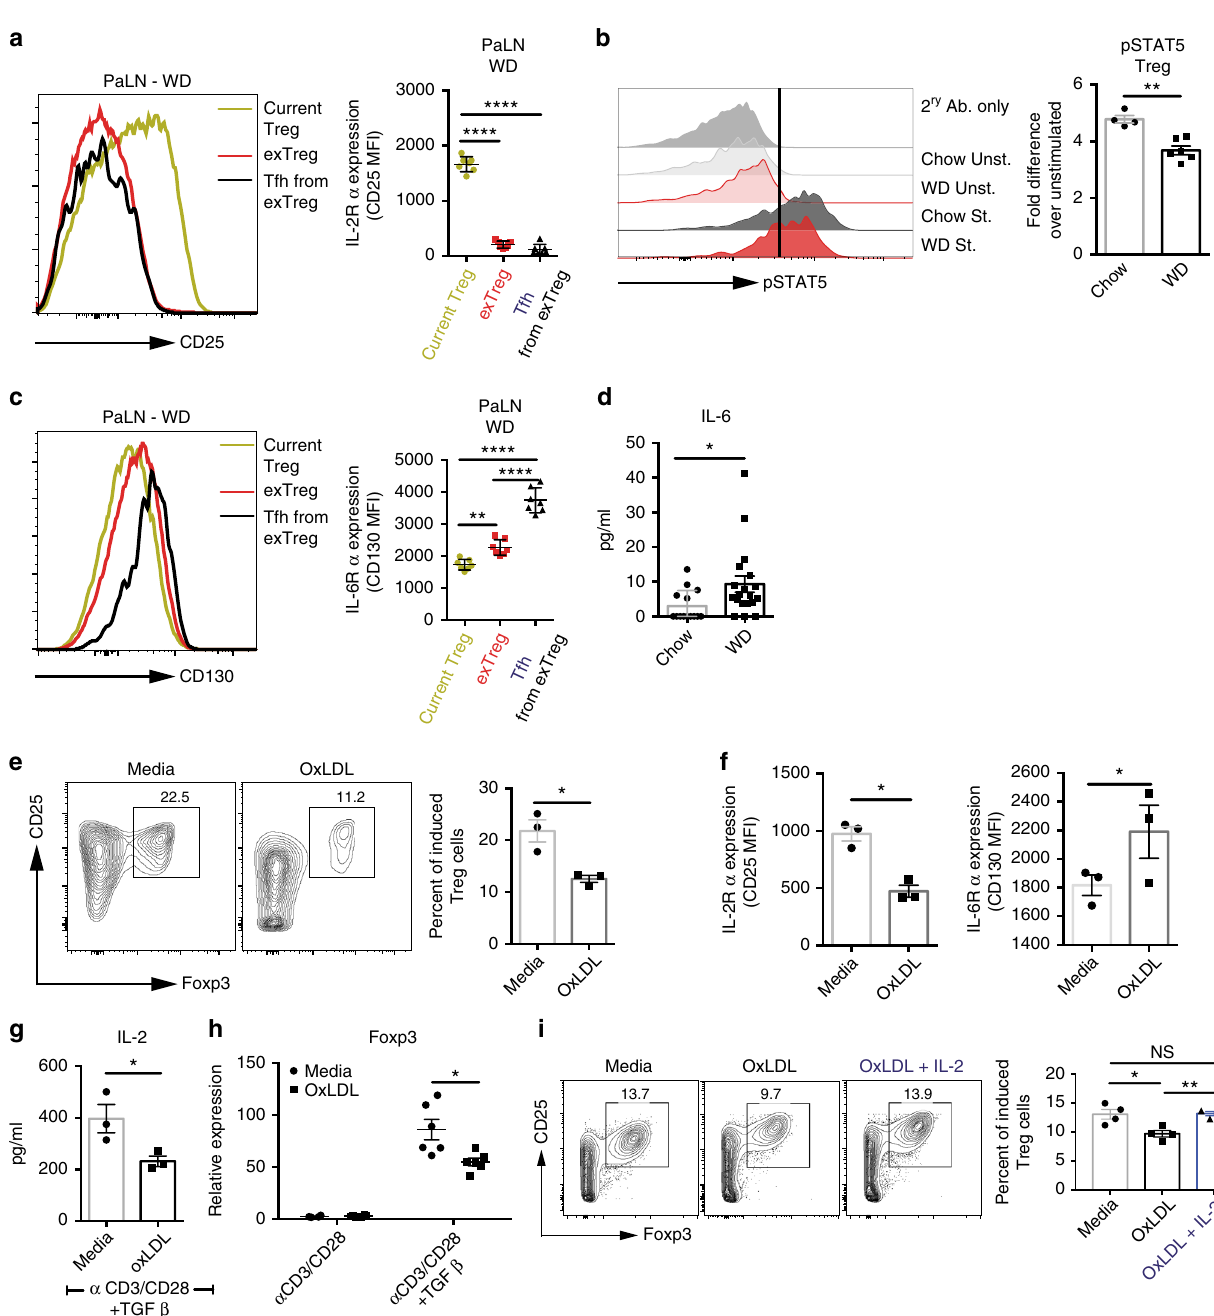
Fig. 5 IL-2 and IL-6 receptors expression is altered between current Treg and exTreg Tfh cells. a Flow cytometry histograms and graphs of mean fl uorescence intensity of IL-2R α (CD25) expression on current Treg, exTreg and exTreg Tfh cells from LT-ApoE − / − mice on western diet. b Histogram plots and differential expression of phosphorylated STAT5 by phospho fl ow in current Treg cells in the western diet-fed and chow controls LT-ApoE − / − following IL-2 stimulation. Graph shows the fold change between unstimulated and IL-2 stimulated samples. c Flow cytometry histograms and graph of mean fl uorescence intensity of IL-6R α (CD130) expression on current Treg, exTreg and exTreg Tfh from LT-ApoE − / − mice on western diet. d Plasma levels of IL-6 in the mice described above. e – i Naive CD4 T cells from ApoE − / − mice were isolated and stimulated with α CD3/CD28 and TGF β to induce Treg in vitro with or without the addition of oxLDL or IL-2. e Flow cytometry plots and graphs showing the percentages of induced Treg following 4 days in culture. f Expression of IL-2R α (CD25) and IL-6R α (CD130) on total CD4 T cells in culture following 4 days of stimulation. h – g Supernatant ( h ) and RNA ( g ) were harvested from the above cultures for the assessment of IL-2 by ELISA ( h ) and Foxp3 mRNA by qRT-PCR ( g ). i Flow cytometry plots and graphs showing the percentage of induced Treg with the addition of exogenous IL-2. Results are expressed as the mean ± s.e.m. from one of two independent experiments ( n = 7) ( a , c ), from one of two independent experiments ( n = 4 (chow) and 6 (WD)) ( b ), from three independent experiments ( n = 14 (chow) and 18 (WD)) ( d ), from one of two independent experiments ( n = 3) ( e – g ) and ( n = 6) ( h ), and one of two experiments ( n = 4) ( i ). Statistical signi fi cant differences were at * P < 0.05, ** P < 0.01, *** P < 0.001, and **** P < 0.0001 (one-way ANOVA) ( a , c , i ) and (Unpaired Student ’ s t- test) ( b , d – h